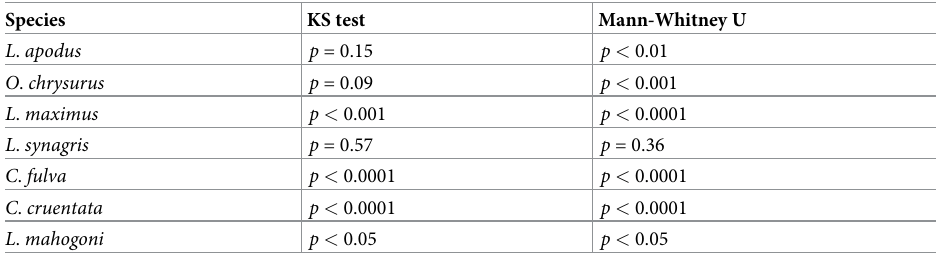
Table 10. LPNR size distribution test